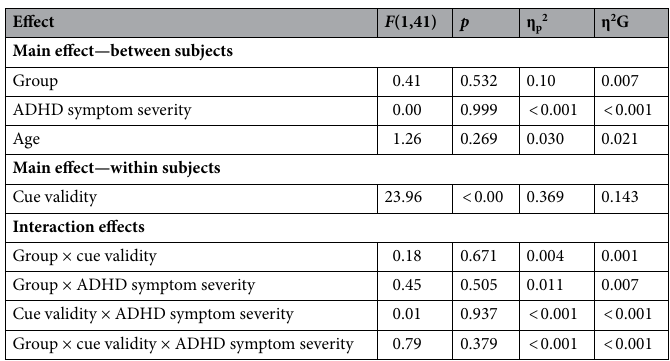
Table 4. The cue validity effect (valid cue vs. invalid cue) and group differences in the cue validity effect on decisional bias (z r ). ADHD: Attention-Deficit/Hyperactivity Disorder.